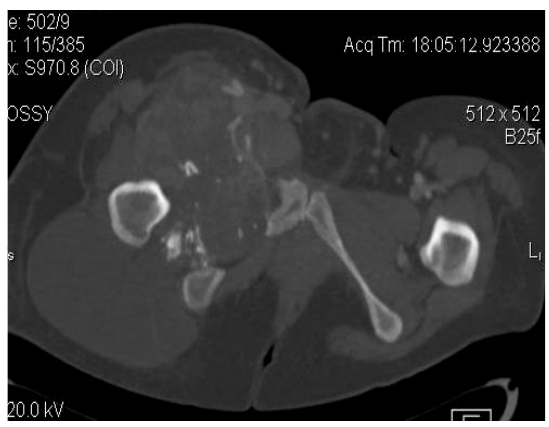
Figure 6. Synovial sarcoma, F, 31 YO patient, CT image, axial section, with contrast—bone window: osteolytic area in the right ischio-pubic rami.